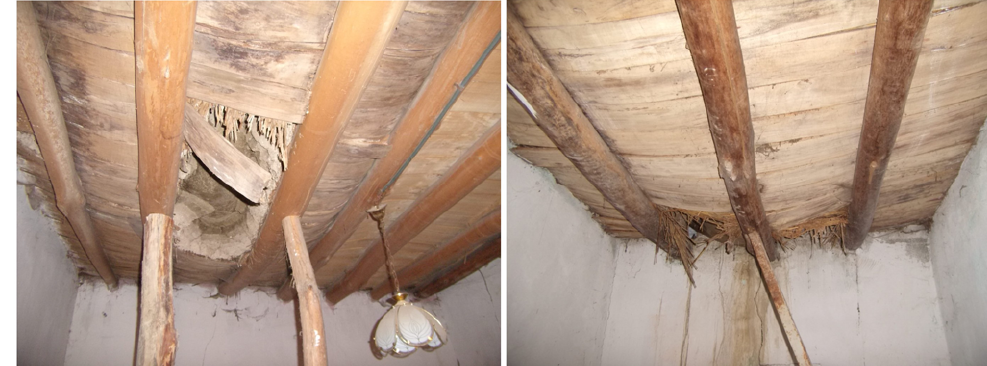
Fig. 21. Partially damages observed in a heavy flat roof system.